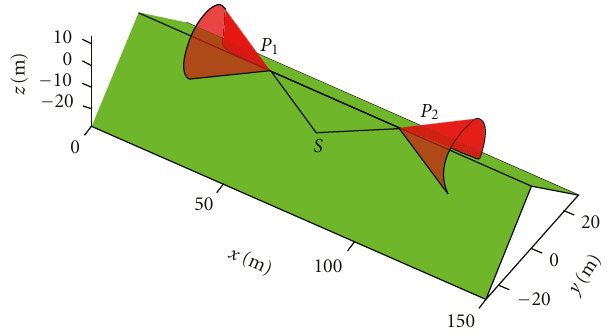
Figure 8: Geometric Theory of Di ff raction: an acoustic source is in S . The acoustic source interacts with the obstacle, producing di ff racted rays. Given the source position S , the points on the edge behave as secondary sources (e.g., P 1 and P 2 in the figure). According to the geometrical theory of di ff raction, the angle between the outgoing rays and the edge equals the angle between the incoming ray and the edge. The envelope of the outgoing rays forms a cone, known in the literature as Keller